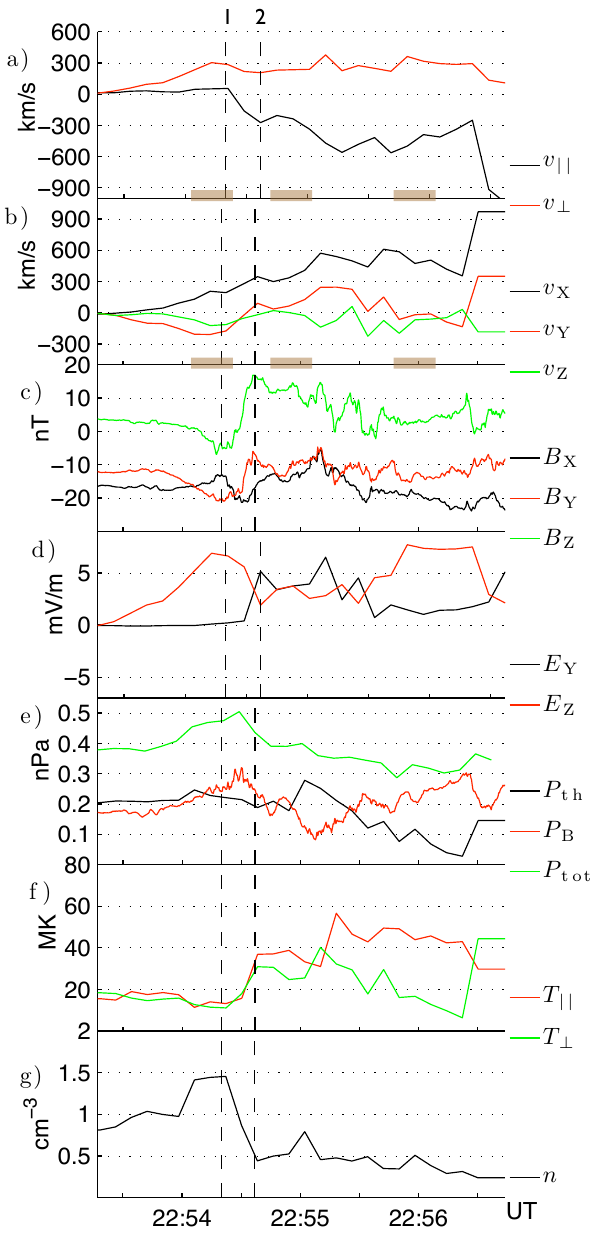
Fig. 6. Measurements from Cluster 1 during the interval 22:53:17– 22:56:44 UT (the interval marked with green background in Fig. 2). The panels show: (a) plasma flow parallel and perpendicular to the magnetic field; (b) GSM components of the velocity; (c) GSM com- ponents of the magnetic field; (d) Y GSM and Z GSM components of the convection electric field ( E =− v × B ); (e) plasma pressure, magnetic pressure and total pressure; (f) temperature components parallel and perpendicular to the magnetic field (g) : ion density. Vertical lines mark the boundary of the flux tube, and brown hori- zontal bars indicate intervals used to generate ion distibution plots shown in Fig.